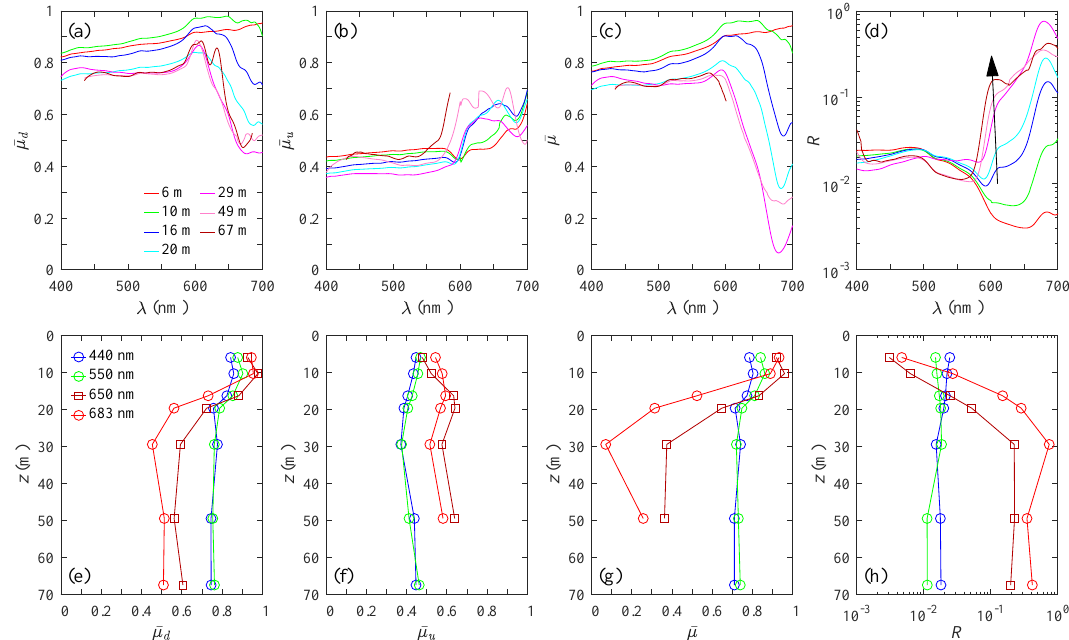
Figure 5. Spectra and vertical profiles of average cosines of underwater light field, µ µ ( c , g ) as well as irradiance reflectance, R ( d , h ), derived from the irradiance quartet for Guaymas Basin shown in Figure 4. In panels ( a – d ) different colors represent depths as indicated in ( a ). The black arrow in ( d ) indicates a spectral feature caused by Raman scattering of water molecules. In ( e – h ) different colors and symbols represent light wavelengths as indicated in ( e